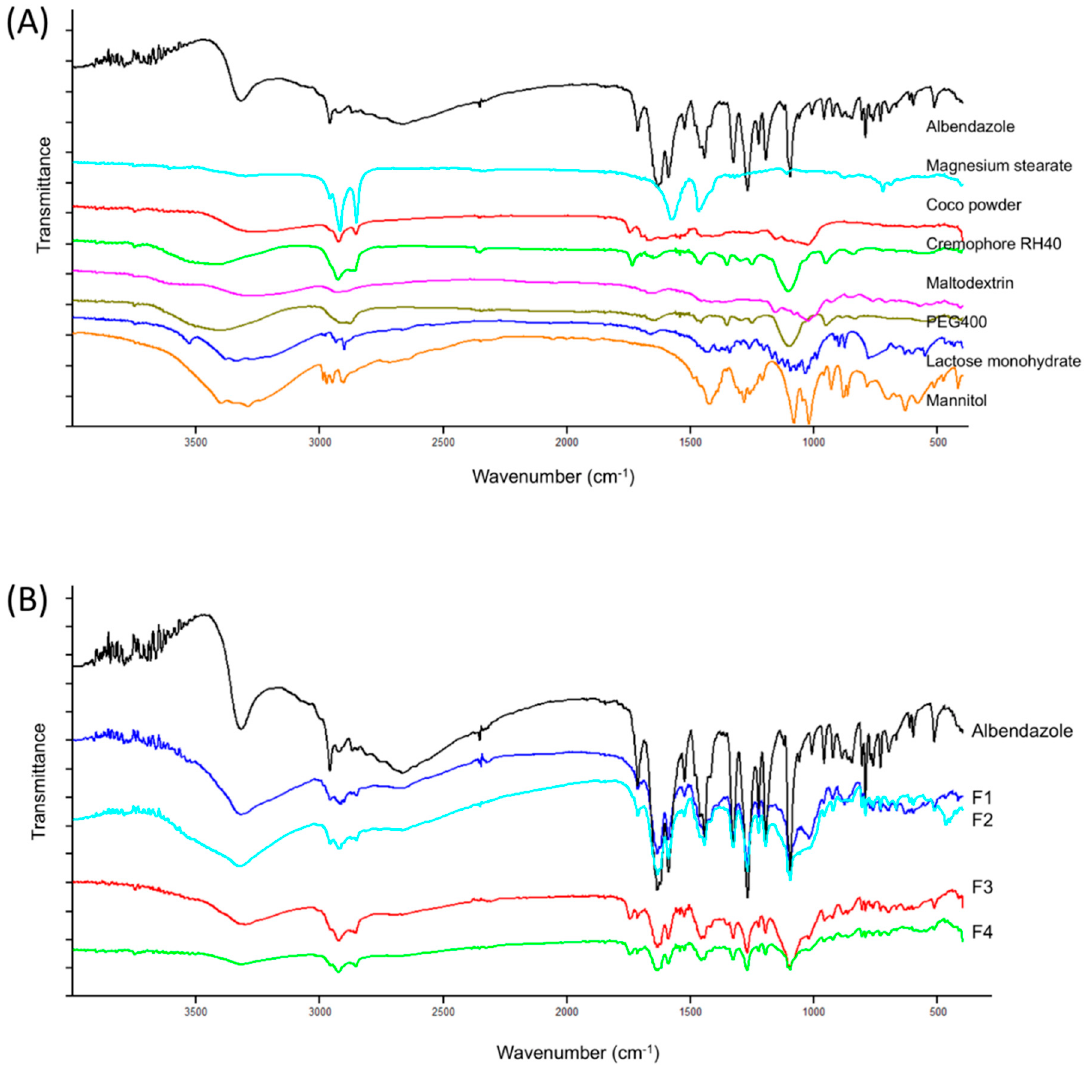
Figure 7. Fourier transfrom infrared (FT ‐ IR) spectrum of ( A ) albendazole and excipients used in the